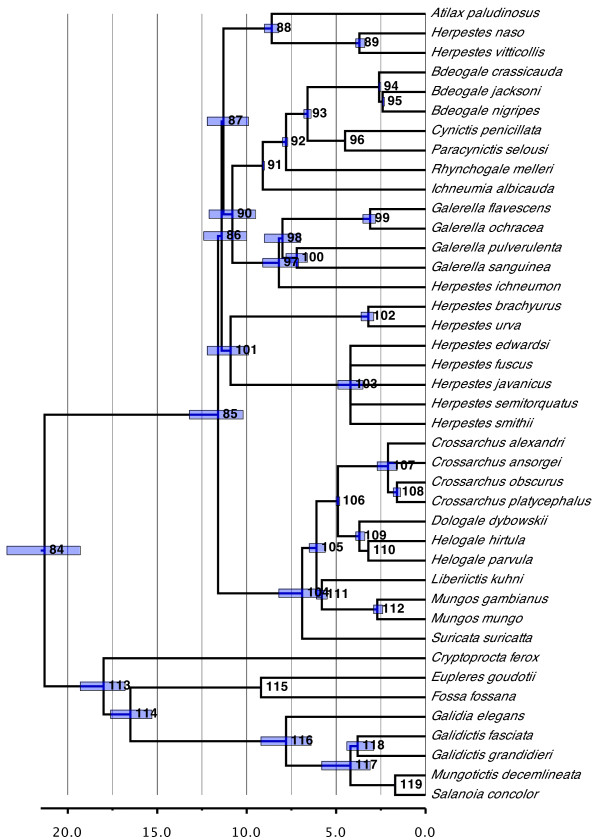
Phylogenetic relationships and divergence times estimates within Eupleridae and Herpestidae. Nodes are individually numbered, with node bars indicating 95% confidence intervals on the divergence time estimates (in Ma before present).